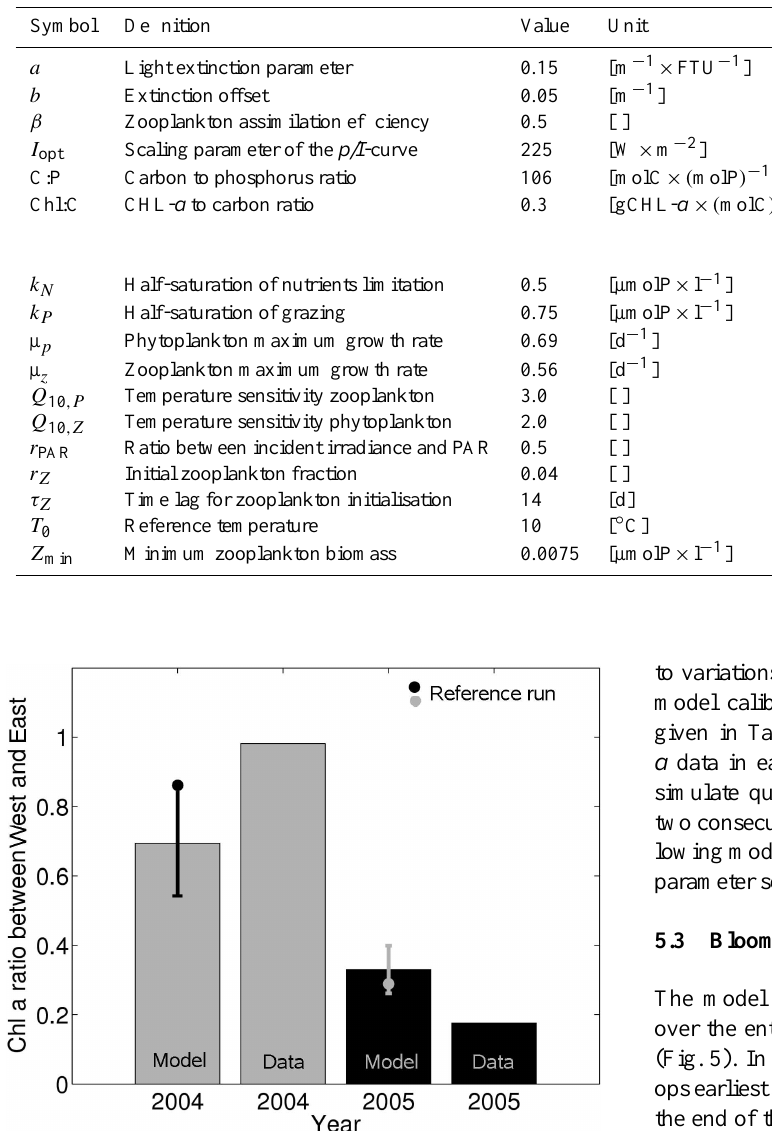
in CHL- a . The gradient is expressed as the ratio of mean CHL- a concentrations in two adjacent areas as shown in Fig. 5. Values below one indicate higher CHL- a in the west than in the east. Error bars show the standard deviation of a total of 162 model runs, solid circles denote the ratios of the reference run. Data bars display the same ratio derived from FerryBox